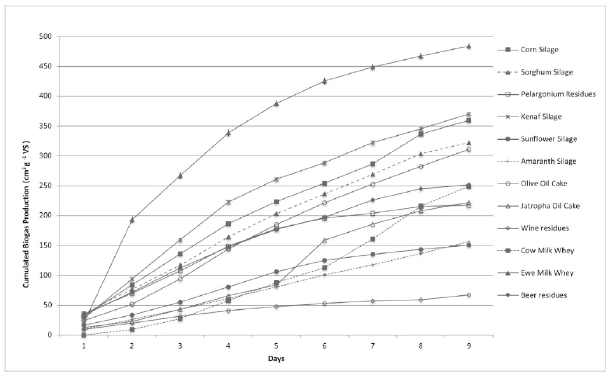
Fig. 4 - Overall tendency of biogas production among the diffe- rent